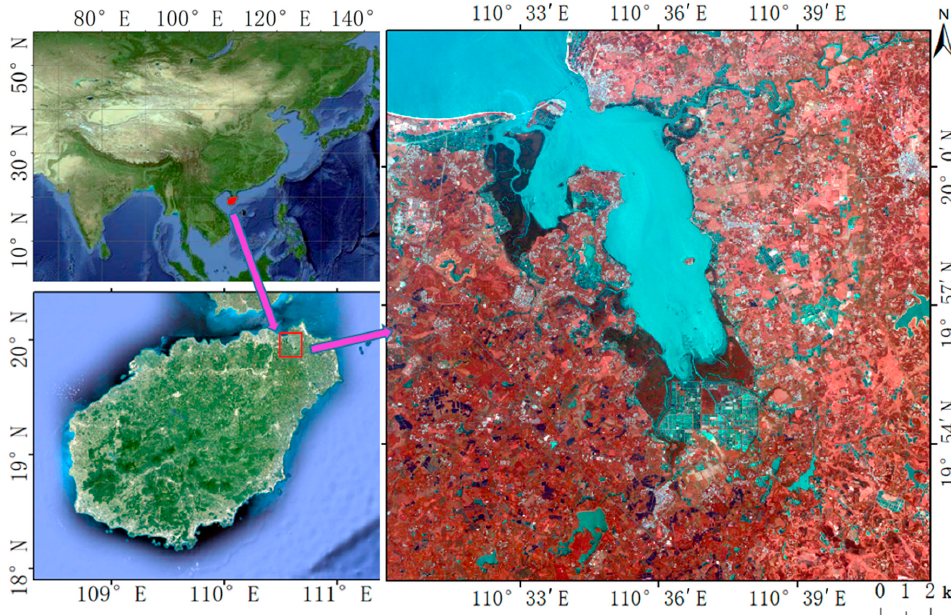
Figure 2. Location and false color combination of 10 m Sentinel-2 data (Shortwave-infrared reflectance (SWIR), G, and B) of the study area.